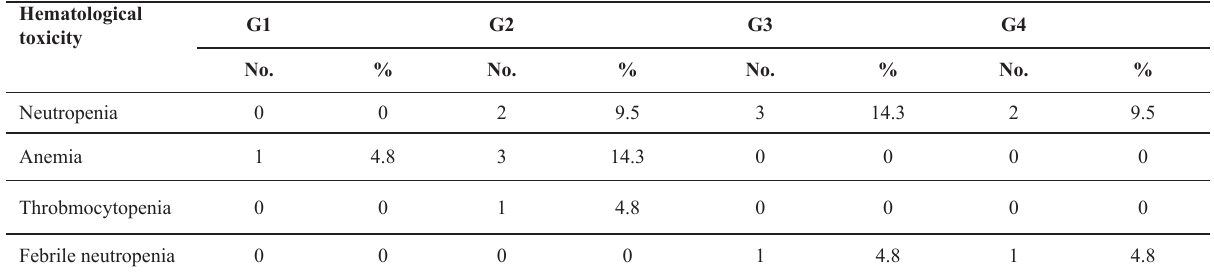
table 3: Hematological toxicity hematological